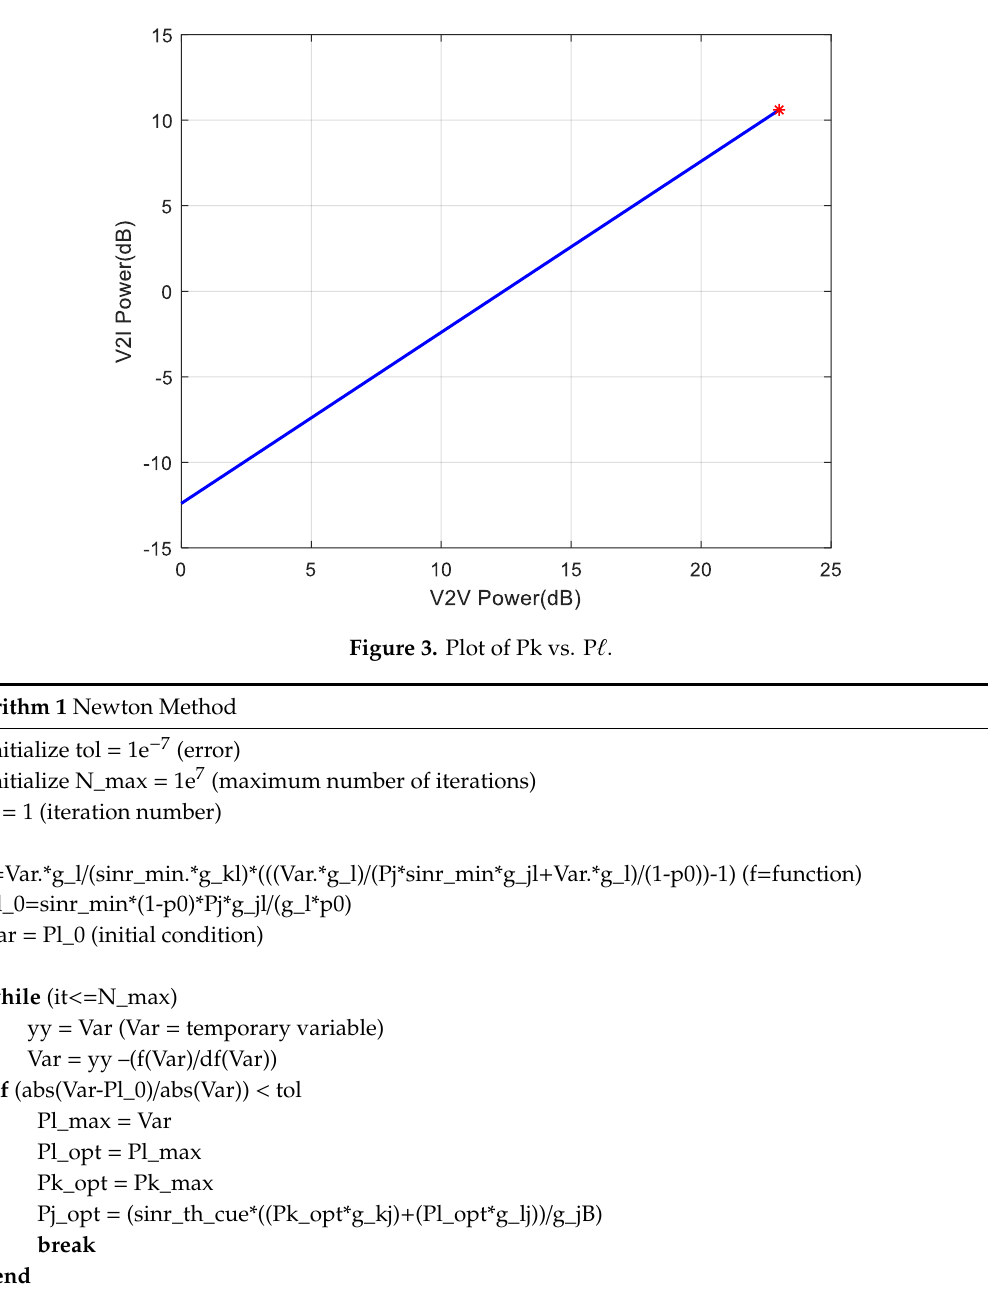
Electronics 2019 , 8 , x FOR PEER REVIEW Algorithm 1.